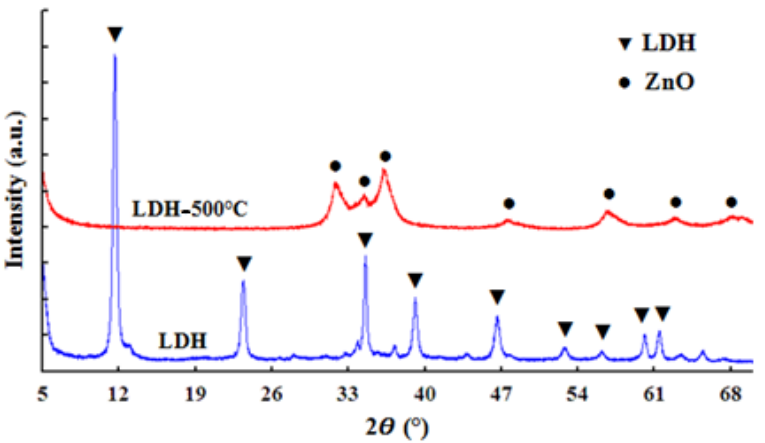
Figure 1. XRD patterns of LDH material before and after calcination at 500 °C.